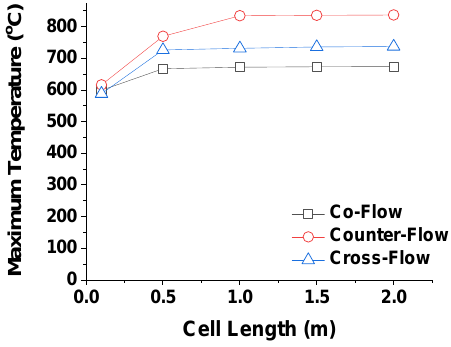
Figure 11. Maximum cell temperatures relative to the length for the co ‐ flow, cross ‐ flow, and counter ‐ flow cell types.